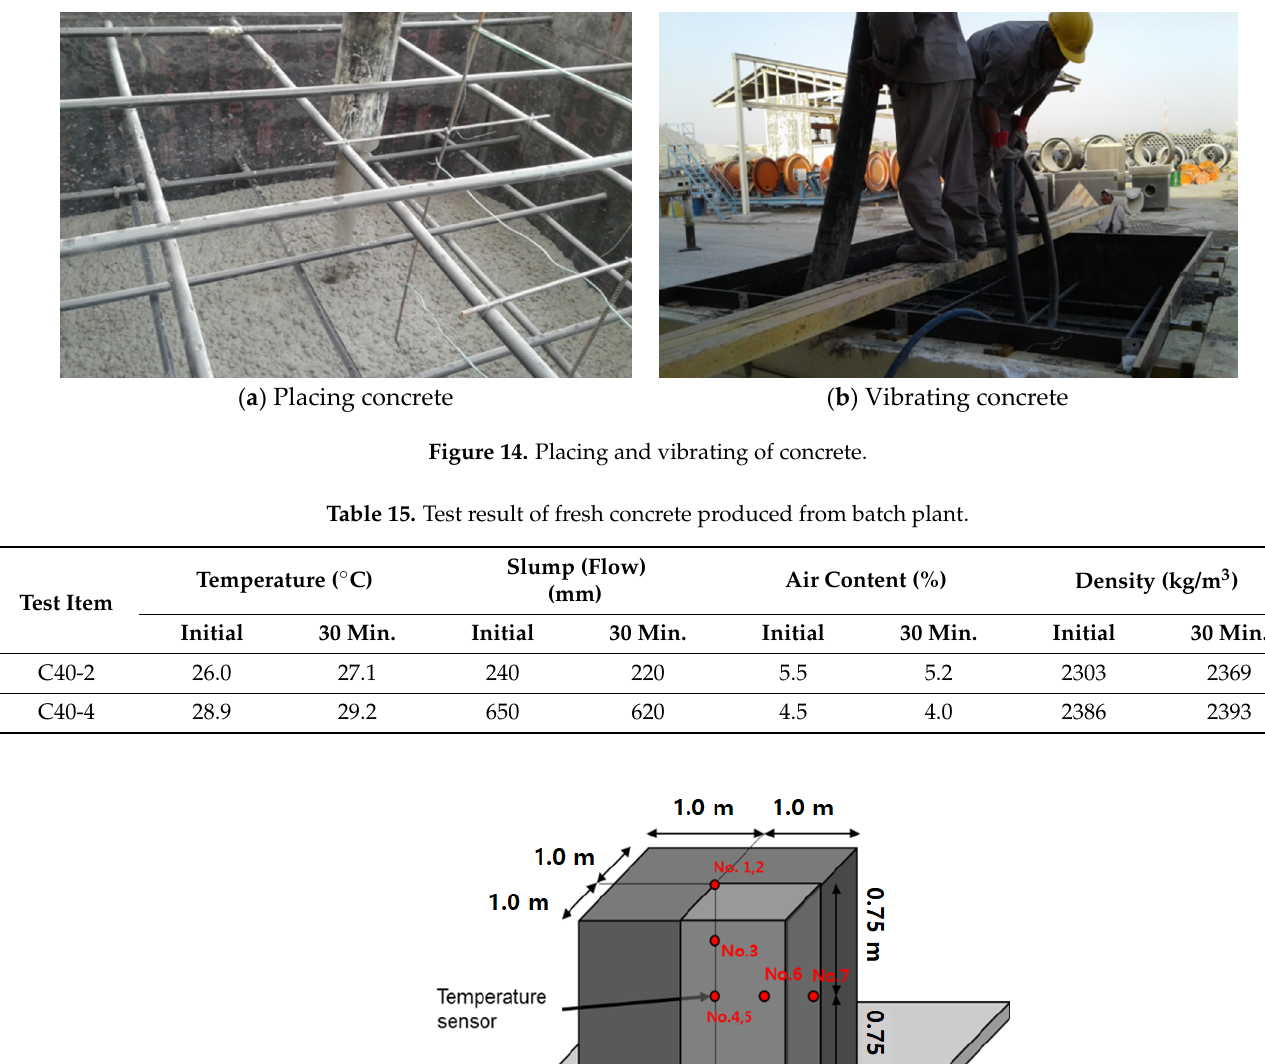
( c ) Side view Figure 13. Dimension of Mock-up specimen. Table 15. Test result of fresh concrete produced from batch plant.